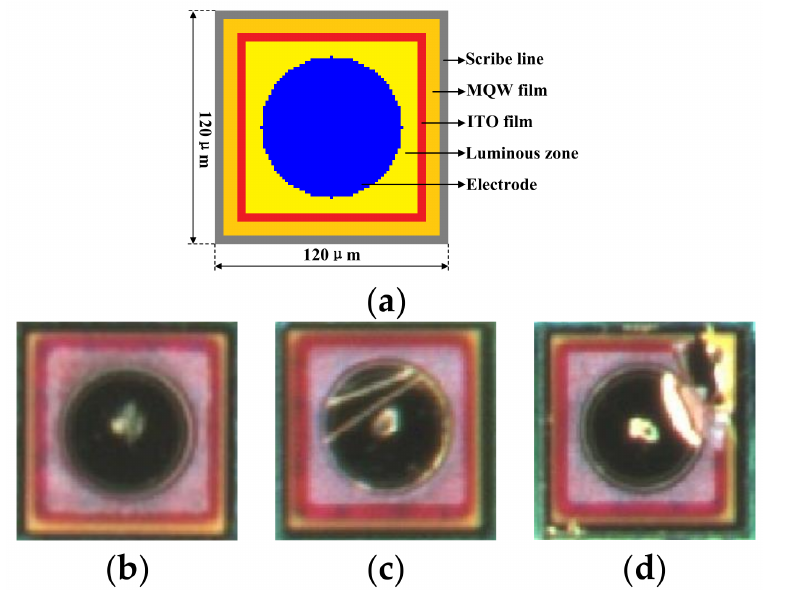
Figure 1. Examples of LED chips: ( a ) sketch of chip; ( b ) normal chip; ( c ) chip with scratches; ( d ) chip with